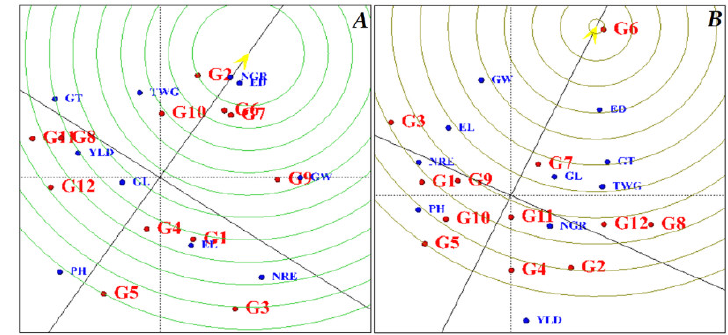
Figure 3. Diagram of the reaction of maize hybrids based on the ideal genotype under normal conditions and water stress. ( A ): normal conditions, ( B ): stress conditions. PH: Plant height, EL: Ear length, ED: Ear diameter, NGR: Number of grains in a row, NRE: Number of rows in-ear, GW: Grain weight, GL: Grain Length, GT: Grain Thickness, TWG: Thousand-grain weight, and YLD: Grain yield. G1: KSC703, G2: KSC260, G3: KSC705, G4: KSC400, G5: KSC706, G6: KSC704, G7: KSC707, G8: DC370, G9: SC647, G10: SC302, G11: SC604, and G12: